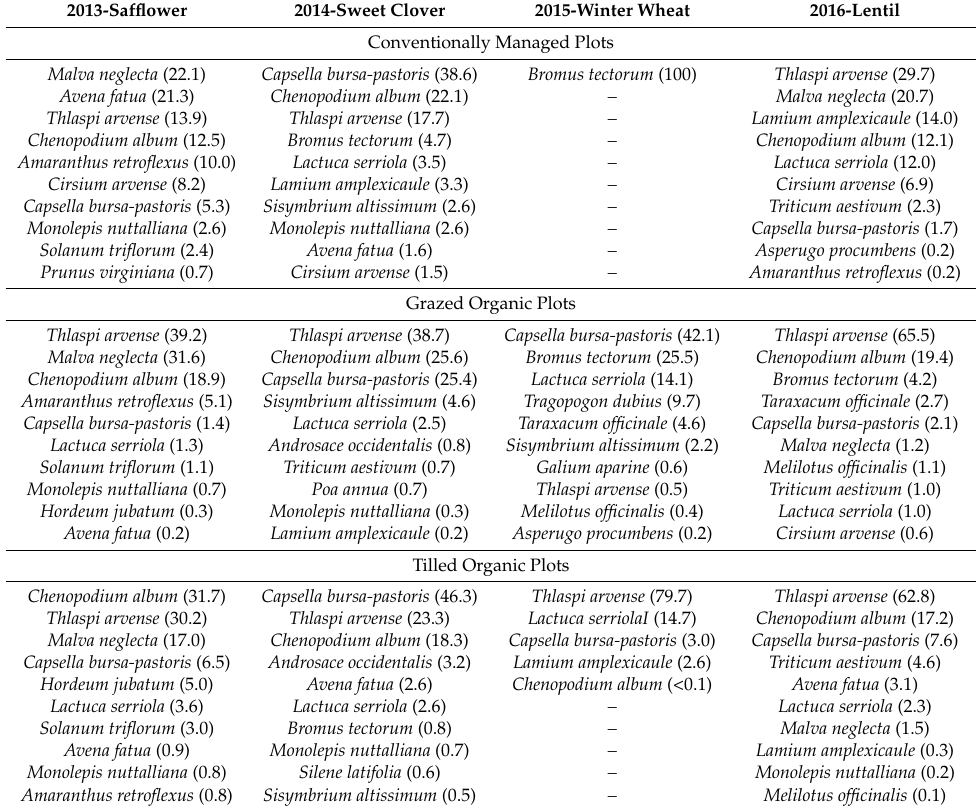
Figure 3. Weed biomass (log transformed) for split-plots that follow the rotation of safflower undersown with sweet clover (2013), sweet clover (2014), winter wheat (2015), and lentil (2016) from three cropping systems at Bozeman, MT, USA. Analysis was performed on log transformed biomass data. Bars marked with the same letters do not differ at p < 0.1 (note: while all rotations were present in the study, only one is shown for clarity). Table 2. Top 10 weed species (by percent of total biomass) in conventionally-managed, grazed organic, and tilled organic plots within the safflower undersown with sweet clover (2013), sweet clover (2014), winter wheat (2015), and lentil (2016) rotation at Bozeman, MT,